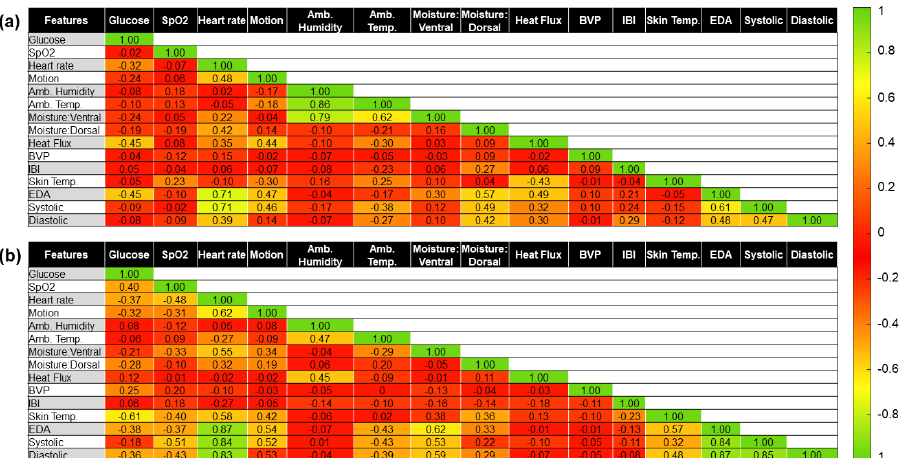
Figure 5. The correlation coefficient between target glucose concentrations and the selected fourteen features for both subjects from the UofM dataset. As before, each regression algorithm of the pipeline is trained using the UofM da- taset. The same 10-fold cross-validation is performed to compare all different models’ fit to this dataset and select the one with lower RMSE (e.g., the best model). Figure 7